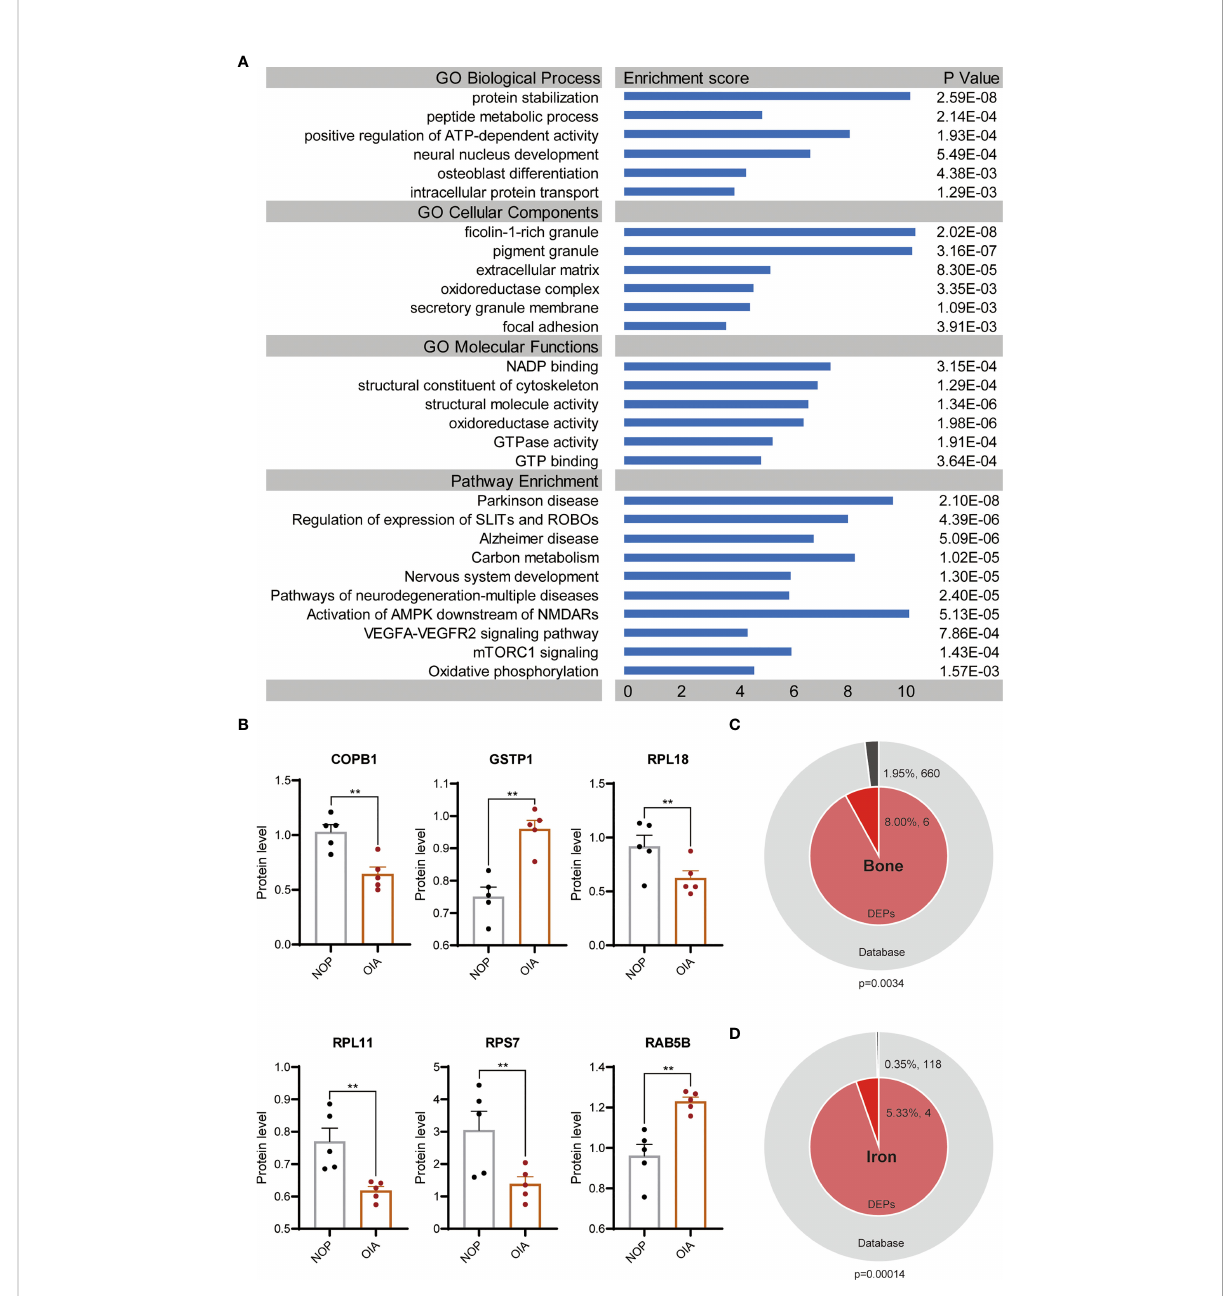
FIGURE 3 GO terms and pathway enrichment analyses of DEPs between OIA and NOP samples. (A) GO and pathway analysis of the 75 DEPS. (B) Changes in 6 top enriched proteins of GO terms in the osteoporosis with iron accumulation. (C) Membership analysis of DEPs associated with bone metabolism. (D) Membership analysis of DEPs associated with iron metabolism.